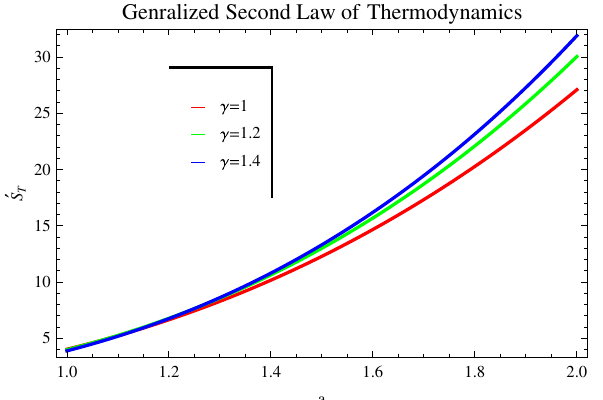
Fig. 2 Plot of S (cid:7)(cid:7) versus a for Bekenstein entropy using k = 1 , λ = T − 1, and b = 1